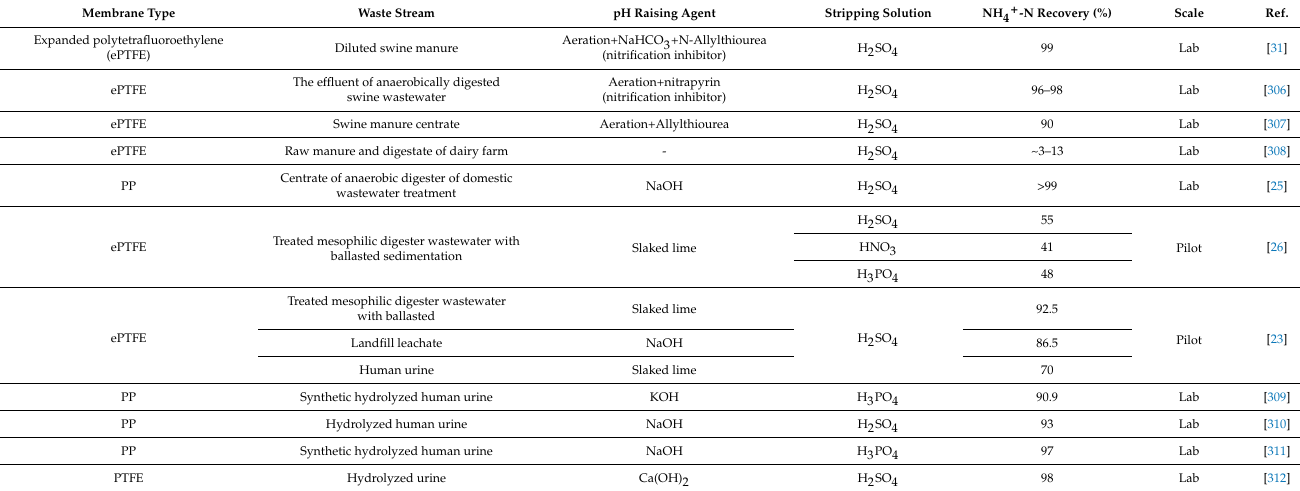
Table 8. Summary of recent studies of nitrogen recovery with membrane contactor.